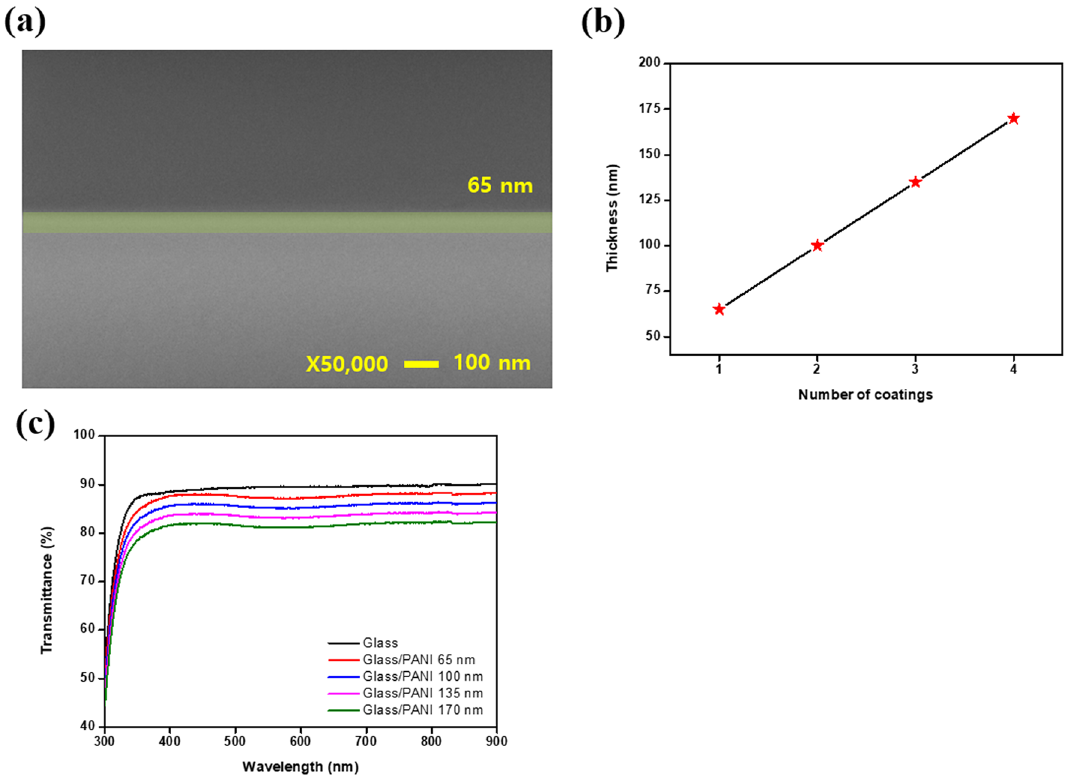
Figure 3. ( a ) The SEM image of the PPL (cross section image). ( b ) The thickness of the PPL and ( c ) the transmittance of the PPL according to its